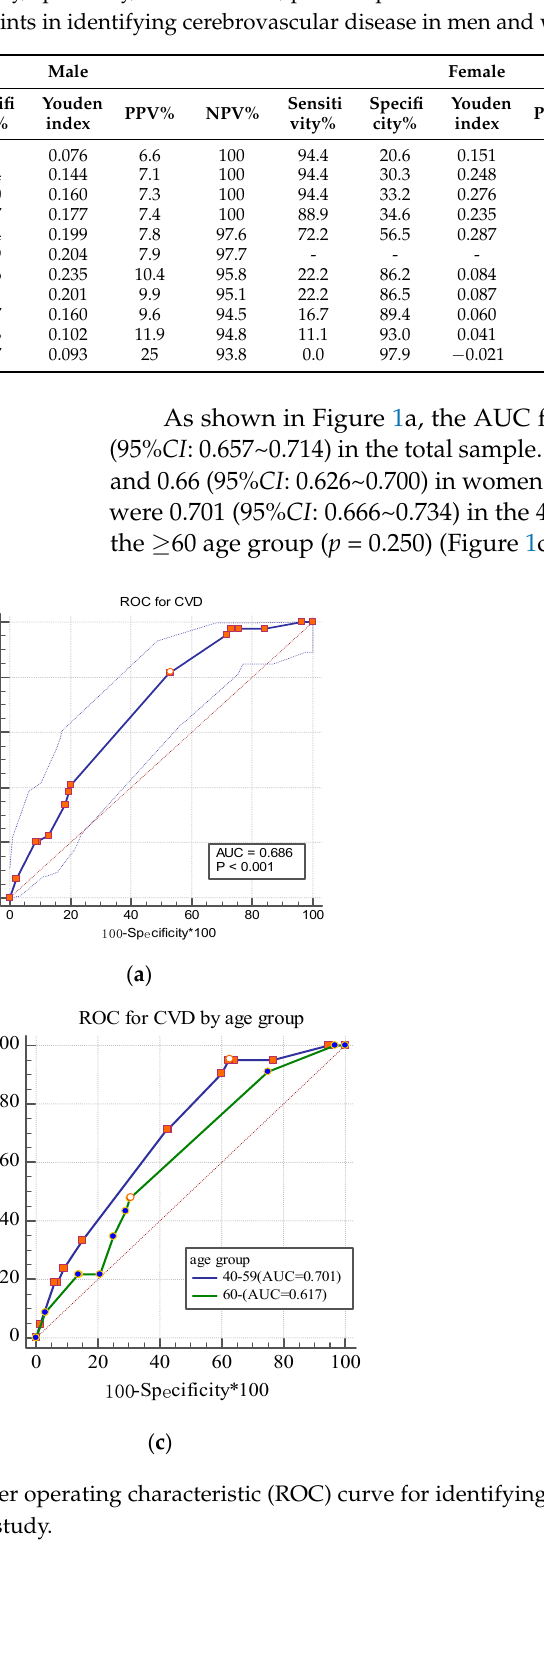
Table 6. The risk levels and the prevalence of the two groups. the optimal positive cut-off point to predict the onset of cerebrovascular disease. The